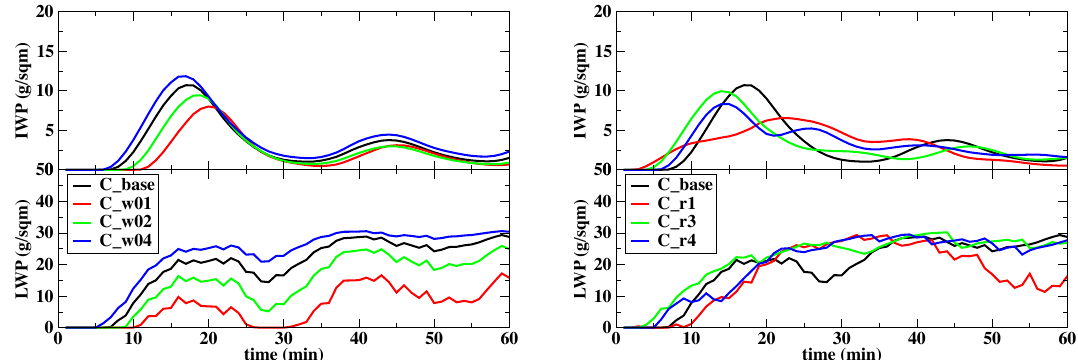
Figure 16. Liquid (lower panels) and ice water paths (upper panels) for case 2. Comparison of the different values for w ave (left) and the different stochastic realizations (right).